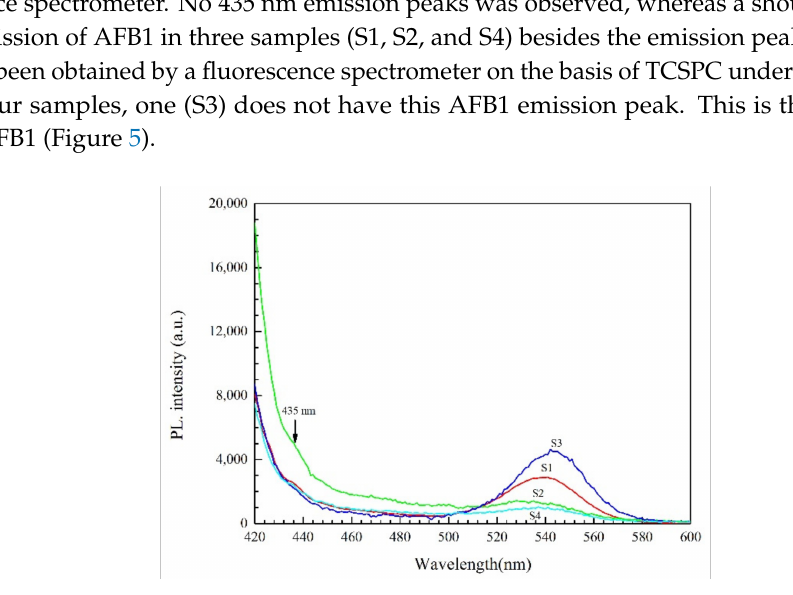
Figure 5. Fluorescence spectra of AFB1 extracted from maize–CdSe / ZnS mixture sample. S1, S2, and